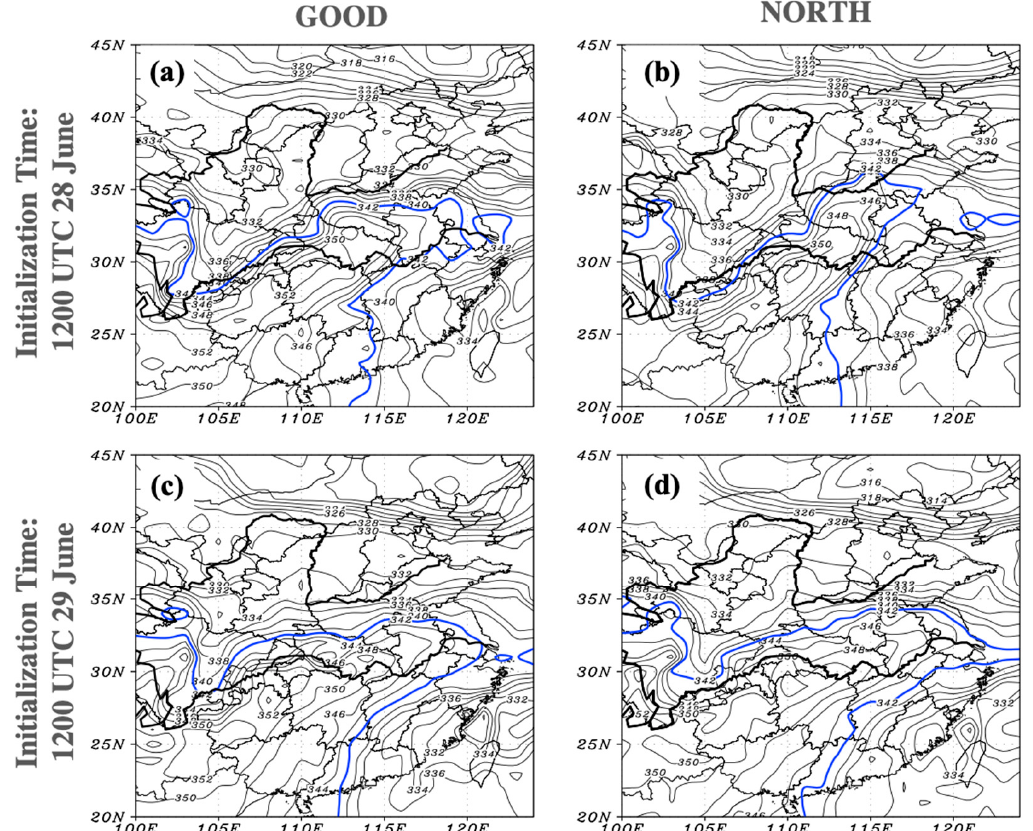
Figure 14. The 700-hPa forecasted pseudo-equivalent potential temperature (K, thin black contour, 2 K contour interval) valid at 0000 UTC 1 July for ( a ) and ( c ) the GOOD subsets, and ( b ) and ( d ) the NORTH subsets selected from the ECMWF operational ensemble initialized at 1200 UTC 28 and 29 June 2016, respectively. Thick blue contour identifies the 342 K pseudo-equivalent potential temperature isotherm. Thin black lines denote political boundaries and thick black lines denote the Huanghe and Yangtze Rivers to the north and south, respectively.